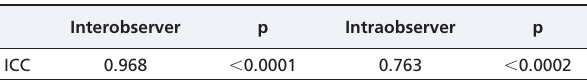
Table 2 - Interobserver and intraobserver reproducibility of the CHFS, as determined using the Intraclass correlation coefficient